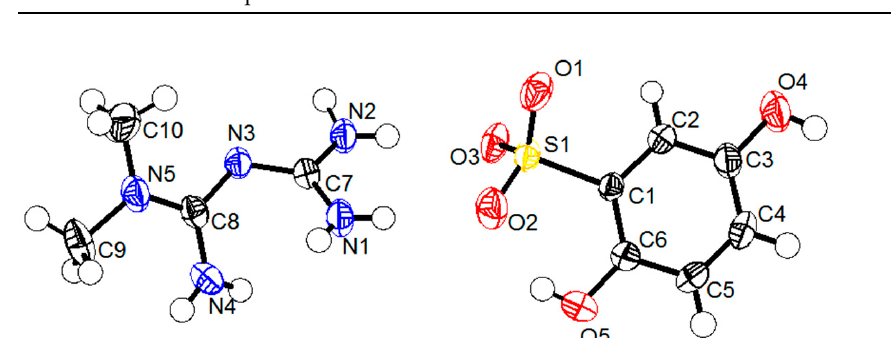
Figure 4. A drug–drug multicomponent crystal of MET–DBS shown at 50% probability ellipsoids.